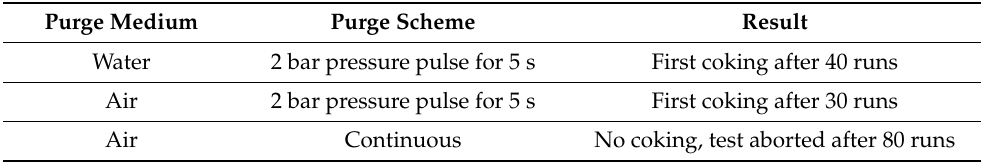
Table 1. Results of coking and purge strategy